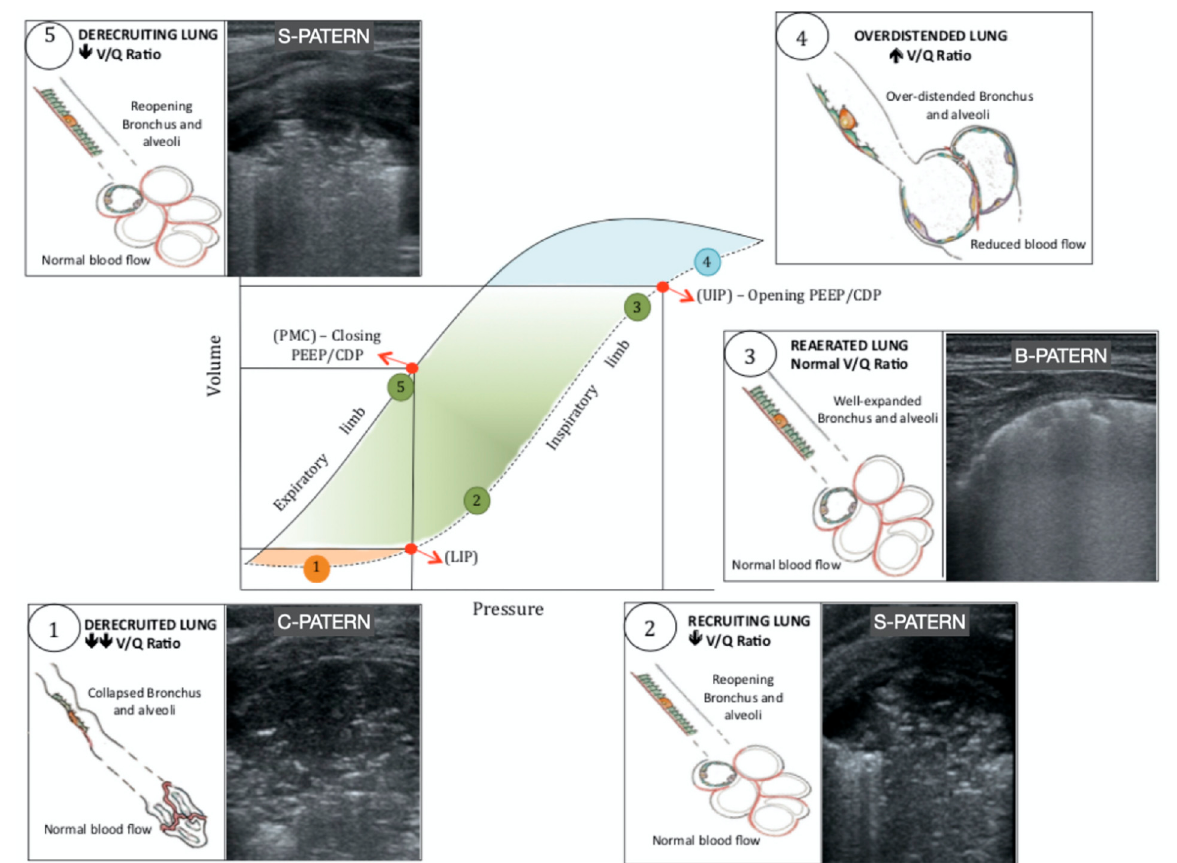
Figure 4. Lung hysteresis and lung ultrasound targeted recruitment (LUSTR). The lung hysteresis represents the difference between the pressure–volume (P–V) curve during inflation (dashed line) and deflation (continuous line). The lower inflection point (LIP) on the inspiratory limb represents the pressure below which lung de-recruitment (C-pattern on LUS) occurs (point 1). Below the LIP, the ventilation/perfusion (V/Q) ratio is decreased because of a reduction in ventilation with normal perfusion. In the recruitable lung, when lung collapse happens for any reason and a lung recruitment maneuver is attempted, a reopening sunray pattern (S-pattern) on LUS starts to appear right above the LIP (point 2). Then, pressure is increased until the S-pattern disappears and the B-pattern develops (point 3). This pressure corresponds to the opening positive end-expiratory pressure (PEEP)/continues distending pressure (CDP) at the upper inflection point (UIP) on the inspiratory limb of the P-V curve The UIP represents the point after which a further increase in airway pressure leads to over-distention without any improvement on lung recruitment. Above the UIP (point 4) the V/Q ratio is increased because of a reduction in blood perfusion due to the compression of lung capillaries by the over-distended alveoli. LUS does not distinguish hyper-expanded from normo-expanded lung. Once lung re-aeration is obtained, PEEP/CDP is reduced until an S-pattern, due to the initial lung de-recruitment, is detected (point 5). This is called closing PEEP/CDP and corresponds to the point of maximum curvature (PMC) on the expiratory limb of the P-V curve. In the ventilated lung, alveoli remain well expanded as long as PEEP/CDP is kept above the PMC and below the UIP. In this range of pressures, the V/Q ratio is